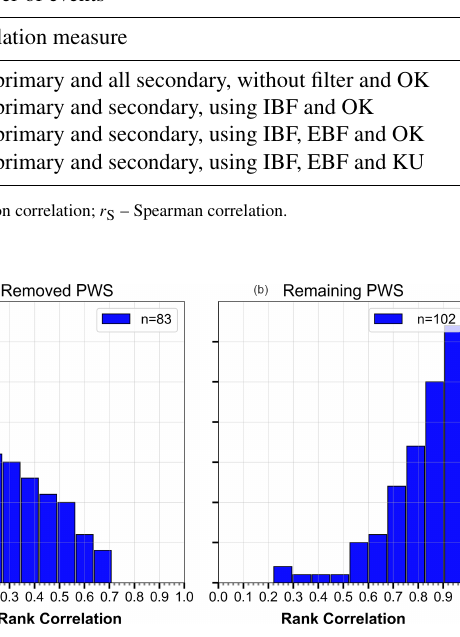
Figure 7. Histograms of the rank correlations between primary sta- tions and PWSs for pairs with a distance less than 2500m. Panel (a) shows the rank correlations for the stations removed by the filter, and panel (b) shows those which were accepted.